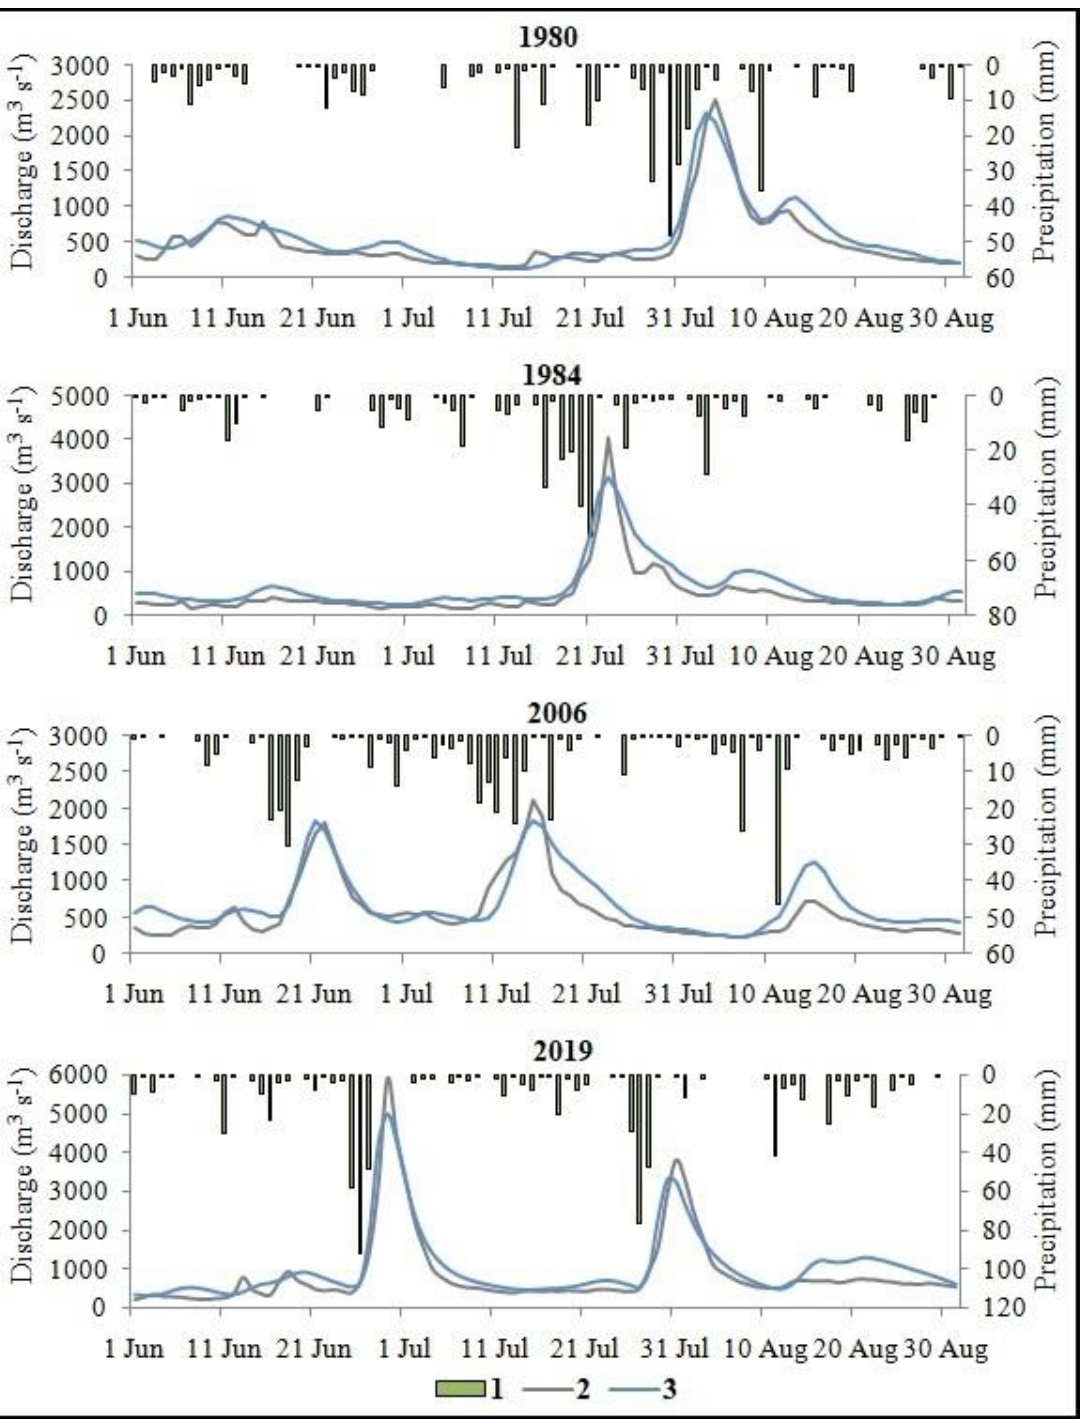
Figure 6. Averaged-basin precipitation (1), observed (2), and simulated (3) discharges of the Iya River at Tulun gauge over summers in 1980, 1984, 2006 and 2019.